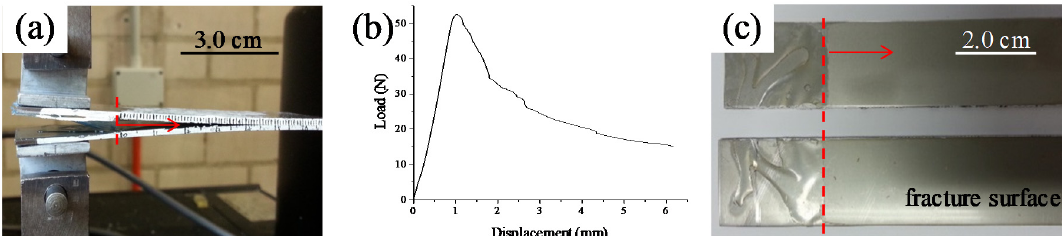
Figure A1 . ( a ) Double-cantilever-beam (DCB) sample used for the determination of adhesive fracture energy J c; ( b ) Load-displacement curves obtained in the DCB test; ( c ) The fracture surfaces after the DCB tests. The dashed red lines and red arrows represent the crack front and crack propagation direction, respectively.